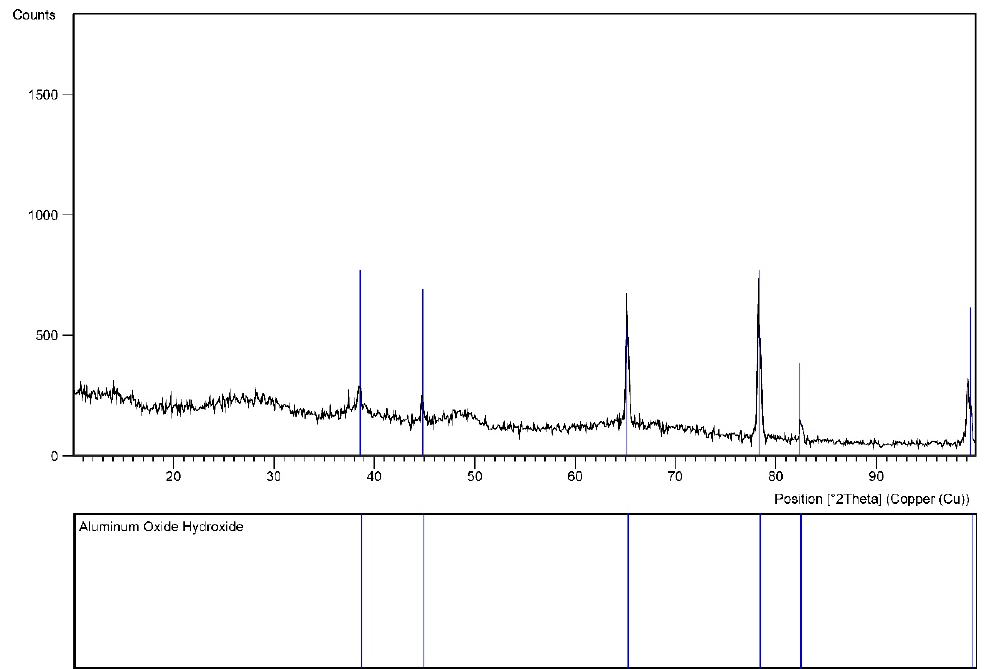
Figure 5. GIXD pattern for the angle of incidence α = 0.50°obtained for the 02G sample subjected to thermo-chemical treatment in distilled water.